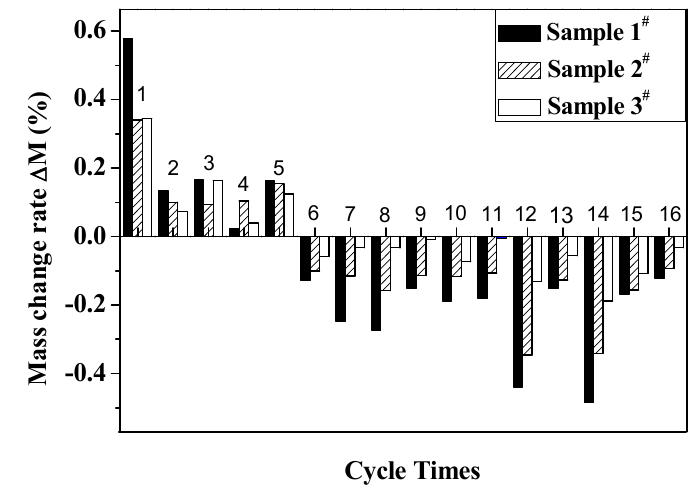
Figure 8. The relationship of mass change rate of samples with the number of cycles.